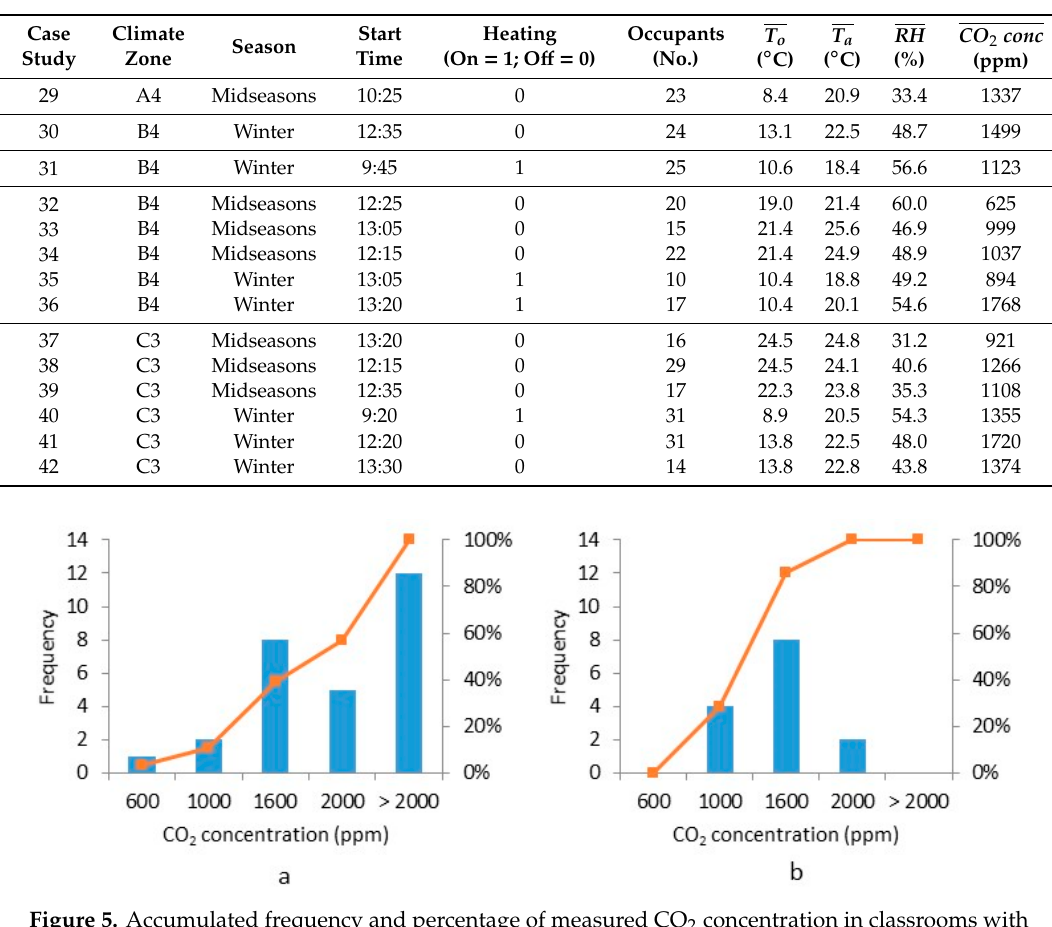
Table3. Averagevaluesofindoorenvironmentparameterswithopenwindowsduringthemeasurement period (45 min per case). Where: “Heating” is the heating system operation (On = 1; O ff = 0); “Occupants” is the number of occupants (No.); “ T o ” is the mean outdoor temperature ( ◦ C); “ T a ” is the mean indoor air temperature ( ◦ C); “ RH ” is the relative humidity ( ◦ C); “ CO 2 conc ” is the mean indoor CO 2 concentration (ppm).